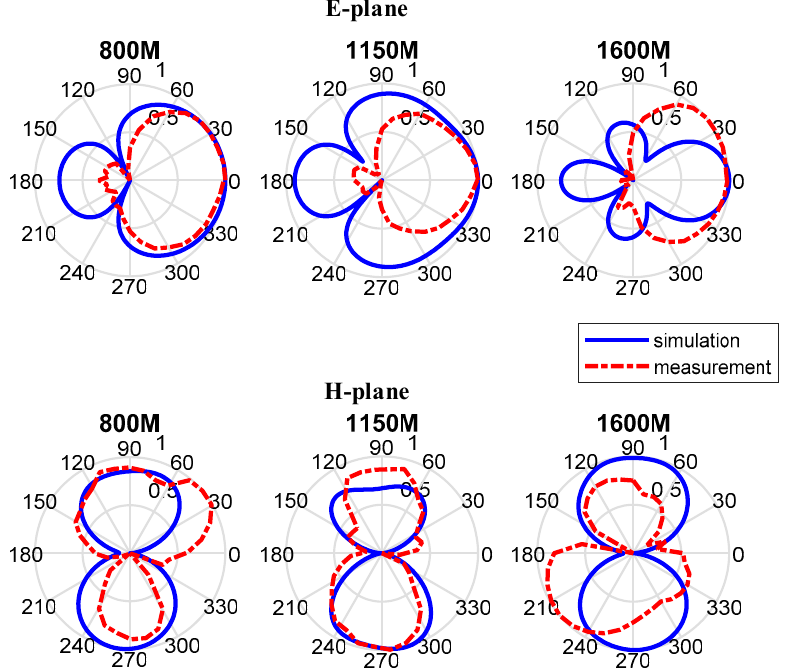
Figure 20. The measured and simulated results of E-plane (upon) and H-plane (below) and it can be found out that the measured back-lobe level at 1600 M at E-plane is considerably reduced as compared to 1150 M and 800 M.